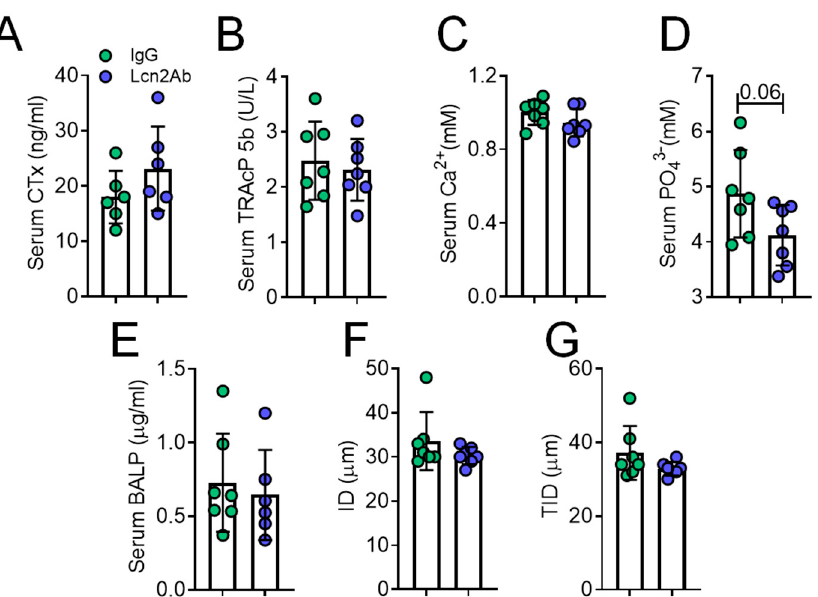
Figure 6. Treatment of MDX with anti-Lcn2 antibody: serum variables. Two-month-old MDX mice were treated with an anti Lcn2 antibody (Lcn2Ab) or an irrelevant IgG (IgG), as shown in Figure 5A. At the end of the experiment, sera were harvested to evaluate ( A ) carboxy-terminal collagen crosslinks (CTx), ( B ) tartrate-resistant acid phosphatase (TRAcP) 5b, ( C ) calcium and ( D ) phosphate ions, and ( E ) bone-specific alkaline phosphatase (BALP). ( F ) Tibiae were explanted and subjected to biomechanical testing via the Biodent reference point indentation analysis instrument to assess indentation distance and ( G ) total indentation distance. Results are the mean ± SD of at least six mice/group; Student’s t -test.